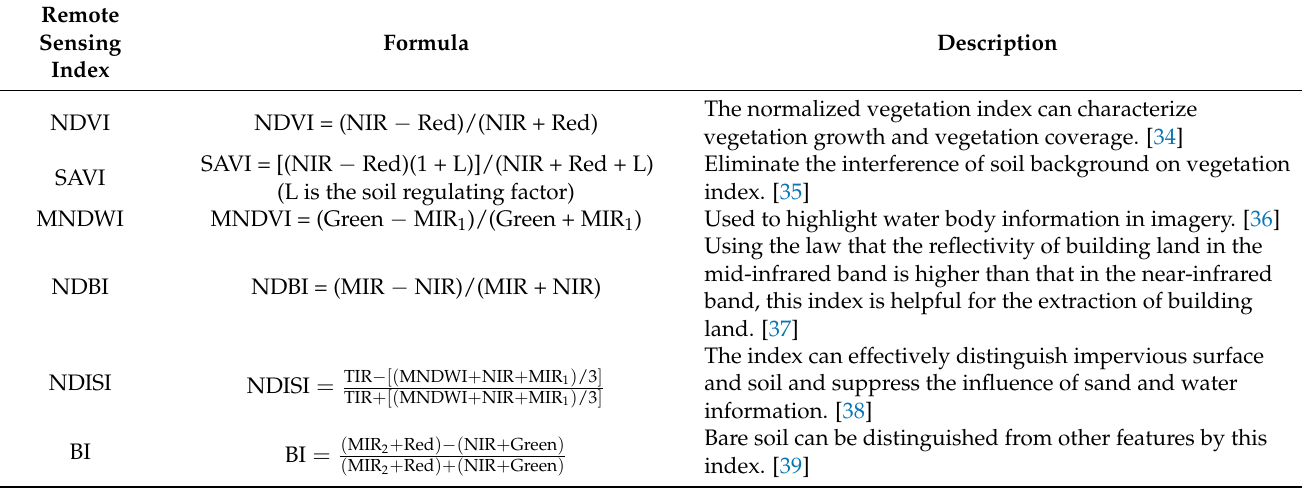
Table 2. Description of spectral indices used in this